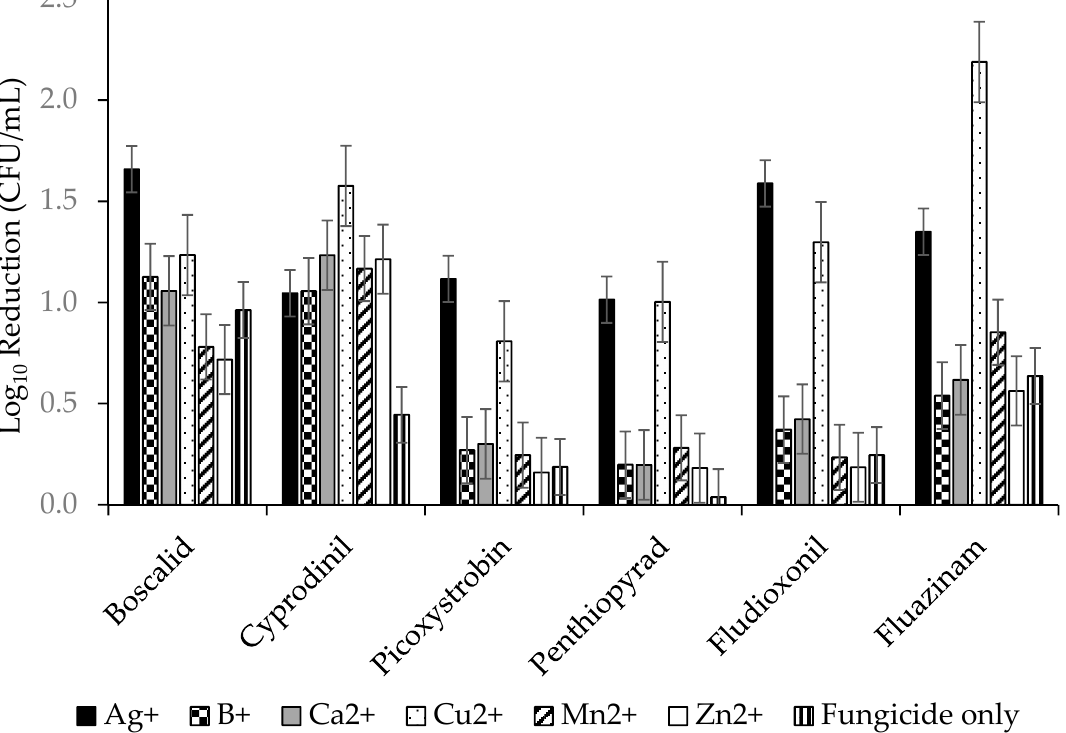
Figure 4. Log 10 (Lg) reductions in CFU / mL for six fungicides in combination with six metals. Error bars represent the standard error of the mean. Table 1. Lg reduction in colony forming units (CFU)/mL in Sclerotinia sclerotiorum biofilms for combinations of four fungicides with six metallic cations. Means that do not share a letter in common are significantly different at p ≤ 0.003 .